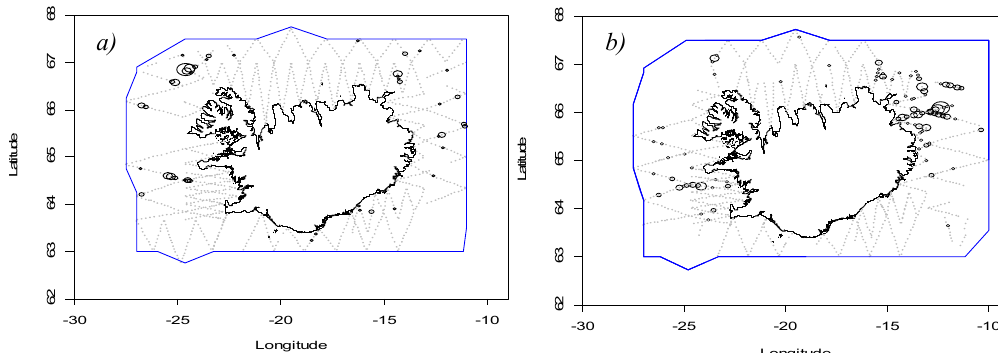
Fig. 1. The realised survey effort (grey lines) and location of sightings (circles) for the aerial surveys in a) 1995 and b) 2001. Observed pod sizes are proportional to the area of the